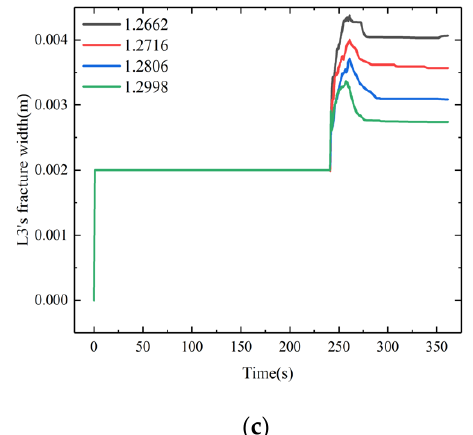
Figure 11. Fracture width variations of CBM reservoirs under various fractal dimensions of natural joints. ( a ) L1, ( b ) L2, ( c ) L3.